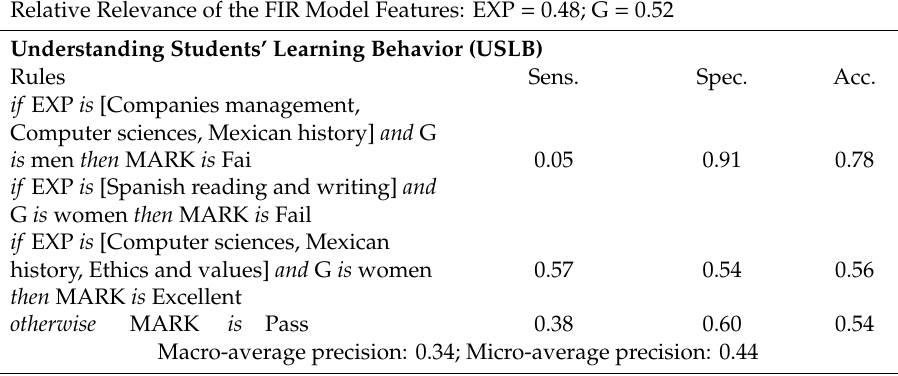
Table 2. ACEP, USLB, ASLP, and GSLB toolbox results for the model 1 of the didactic planning course. The MARK variable was discretized into three classes: fail (from 0–6), pass (from 6.1–8.9), and excellent (from 9–10). AGE variable was discretized into two classes: young (up to 35) and mature (more than 35). The rest of the variables are discrete, so each value corresponds to a class. Spec., Sen. and Acc. stand for specificity, sensitivity, and accuracy,